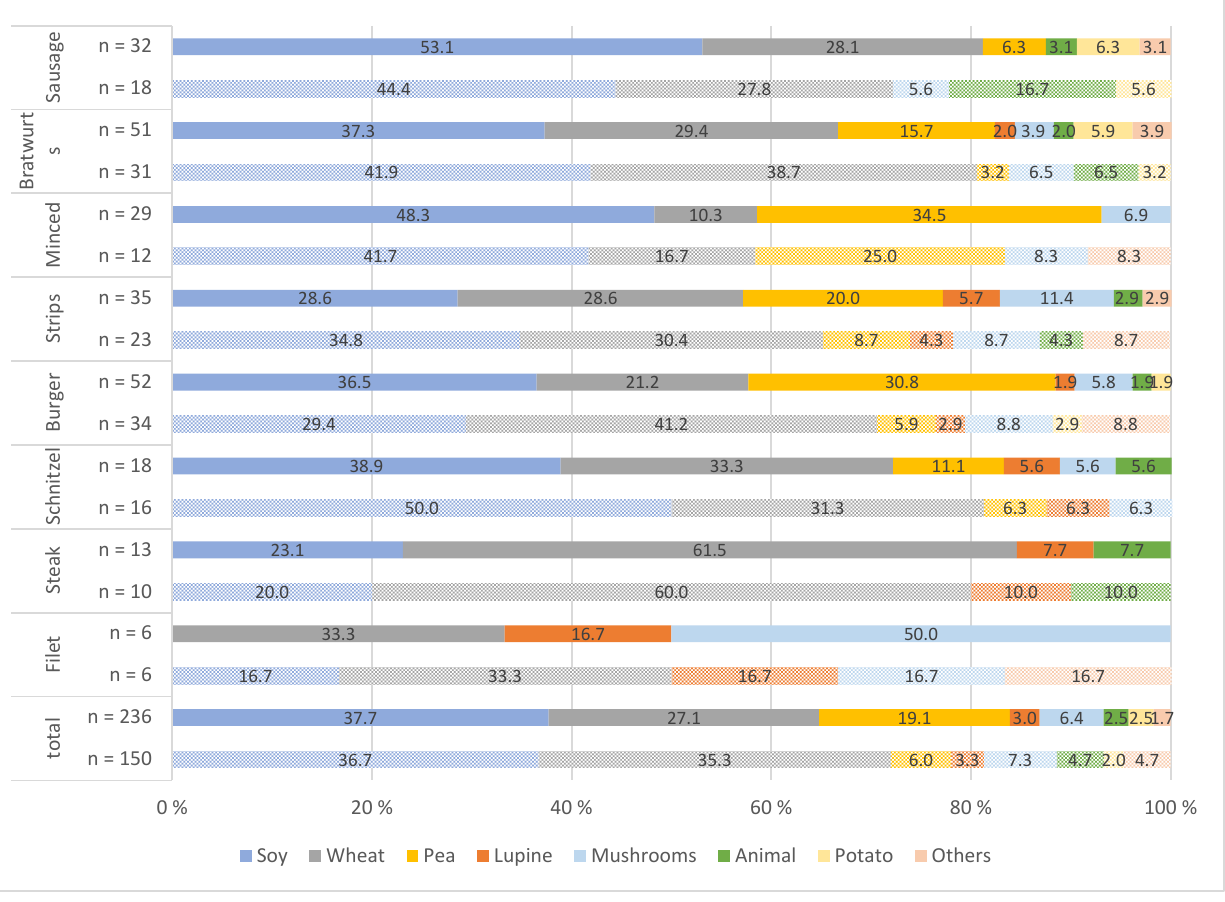
Figure 1. Protein sources used in plant-based meat alternatives (PBMA-hot) in 2019 (patterned color) and 2021 (solid color) (%); n = number of products; animal = milk or/and egg protein; others = beans, sunflower and pumpkin seeds.